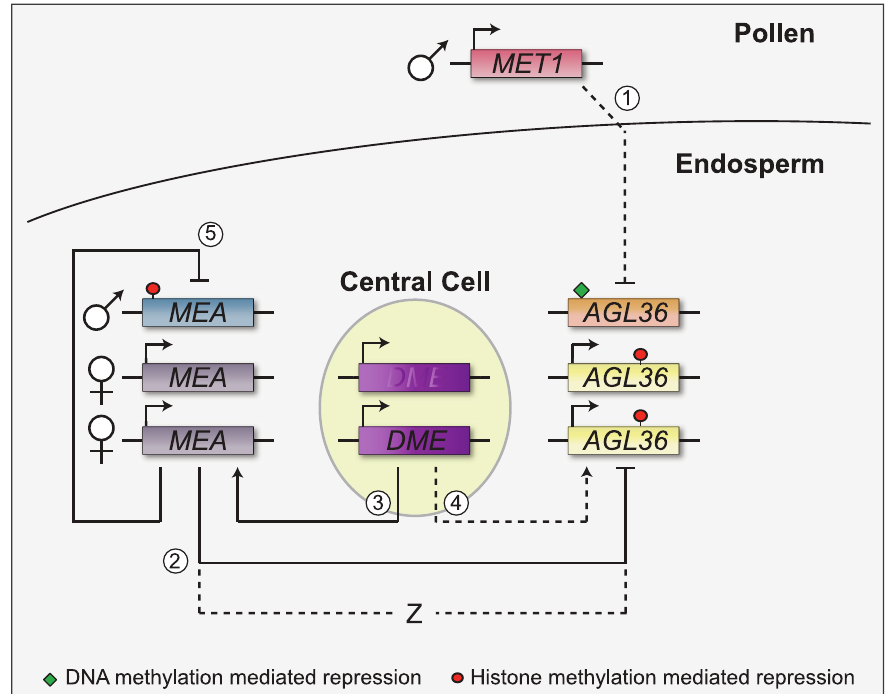
Figure 8. A model for the imprinted expression of AGL36 . Paternal silencing of AGL36 is maintained by the action of MET1 in the male germline prior to fertilization (1). The maternal copy of AGL36 is repressed after fertilization, either directly or indirectly, by the maternally expressed FIS-complex (2) (only MEA is indicated in the figure). DME is expressed only in the central cell and activates the maternal allele of MEA and AGL36 (3 & 4). The autoregulatory repression of maternal MEA upon paternal MEA is indicated (5). Solid lines indicate direct regulation. Dashed lines indicate possible indirect regulation.